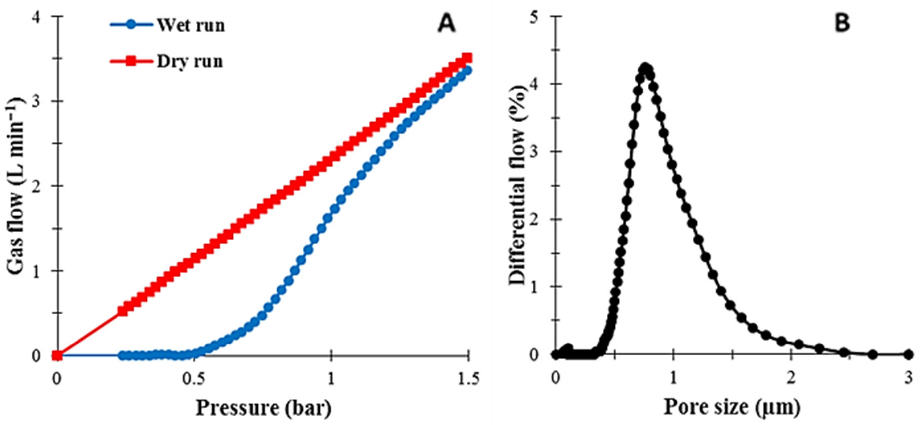
Figure 3. Results of the bubble point method for the PA6 membrane: ( A ) gas flux in wet and dry runs; ( B ) pore size distribution.